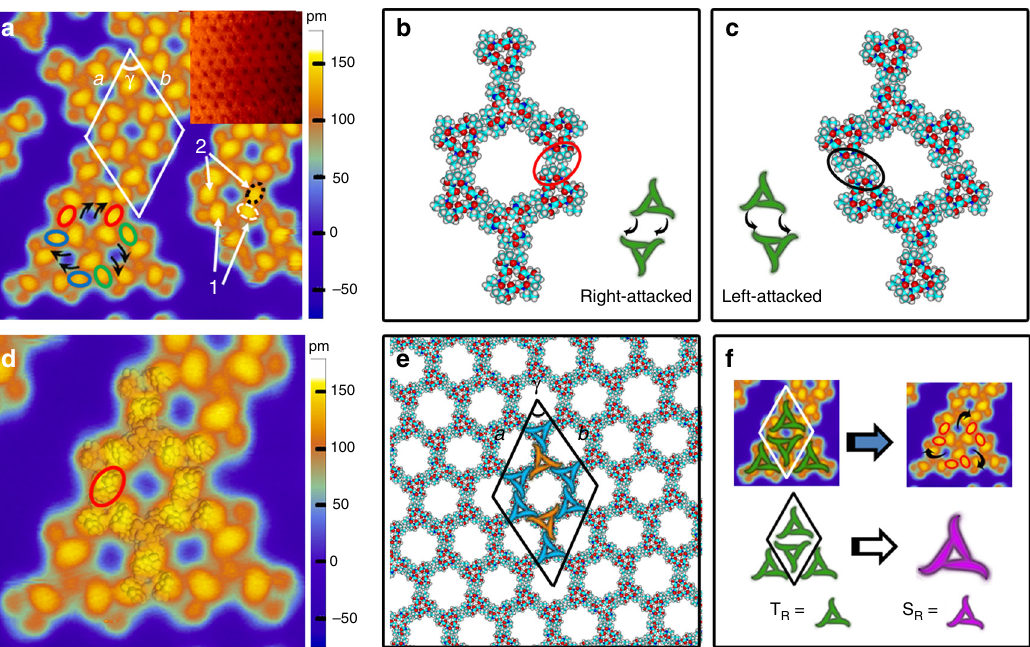
Fig. 3 Valinomycin supramolecular networks. a High-resolution STM image (20 nm × 20 nm) of valinomycin supramolecular networks. As supplement, STM image (25 nm × 25 nm) of an intact valinomycin supramolecular network was also inserted in the top right corner. The directional binding of tetramer building blocks are marked by three groups of oval circles with red, blue, and green colors, and black arrows. The binding sites at the fi rst and second level of assemblies were marked by white and black dashed circles, respectively. b, c Two typical calculated molecular models of T R pair. Right-attacked mode and left-attacked modes were displayed in b and c , respectively. Their binding sites between T R subunits were separately highlighted by a red circle and a black circle. d STM image (12 nm × 12 nm) of valinomycin supramolecular network superimposed by the calculated electron density of T R pair. The binding site between T R subunits was highlighted by a red circle. e Calculated molecular model of valinomycin supramolecular networks. A schematic unit cell was superimposed on the model of the supramolecular networks. f Schematic diagram of the chirality transmission at the second level of hierarchical assembly. In calculated molecular models, carbon, nitrogen, oxygen, and hydrogen atoms are displayed in cyan, blue, red and gray, respectively. Note: In order to clearly display the calculated molecular models of valinomycin networks, the Cu(111) surfaces have not been